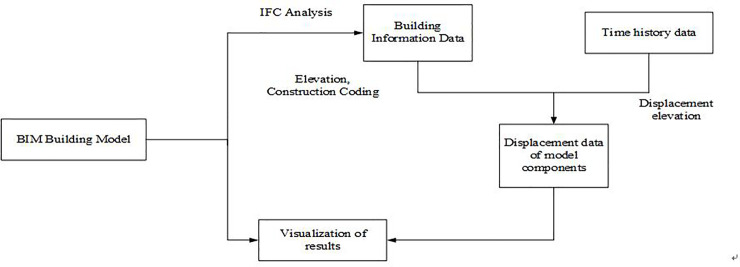
Geologic hazard homestay construction model based on BIM technology.